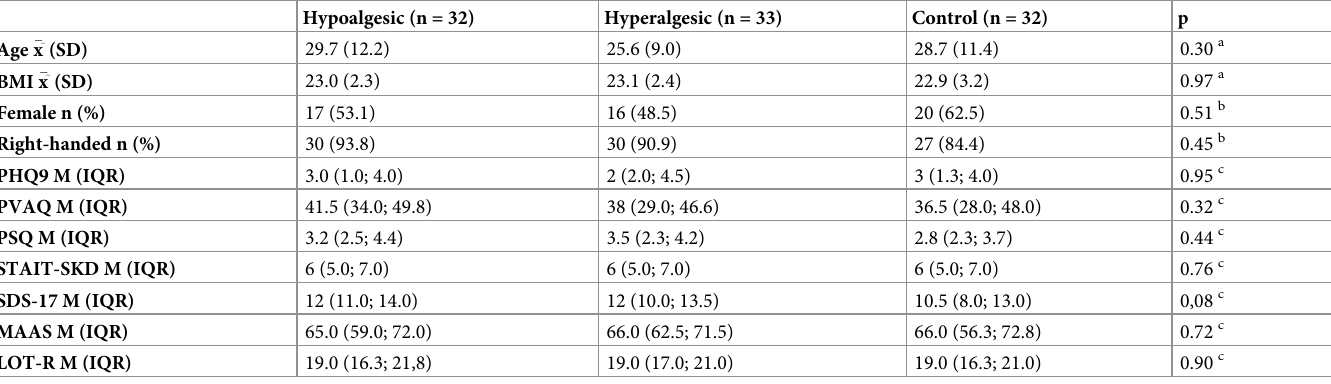
Table 1. Participant characteristics for each